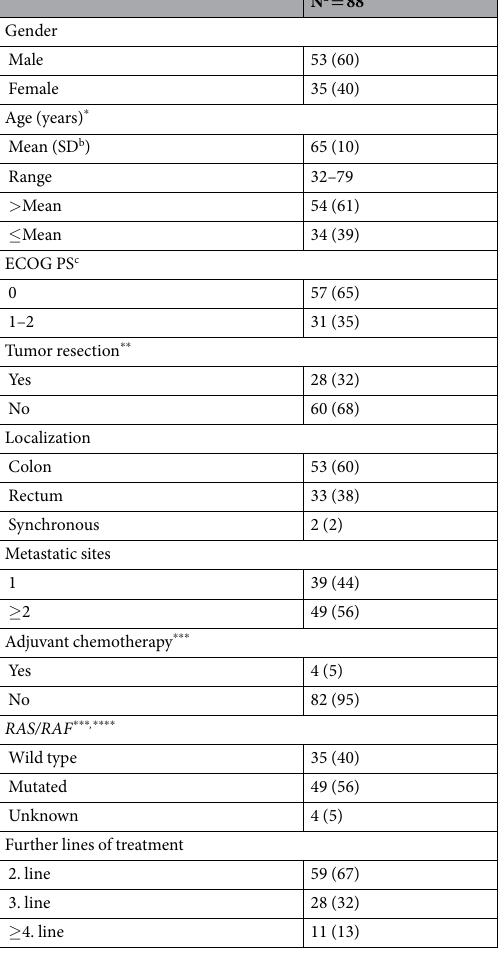
Table 1. Patient characteristics. N a , Number; SD b , Standard deviation; ECOG PS c : Eastern Cooperative Oncology Group performance status. Not all sums of percentages equal 100% due to rounding of data. * Age at start of treatment. ** Primary tumor previously resected. *** Data registration incomplete. **** Includes KRAS, NRAS, and BRAF mutational